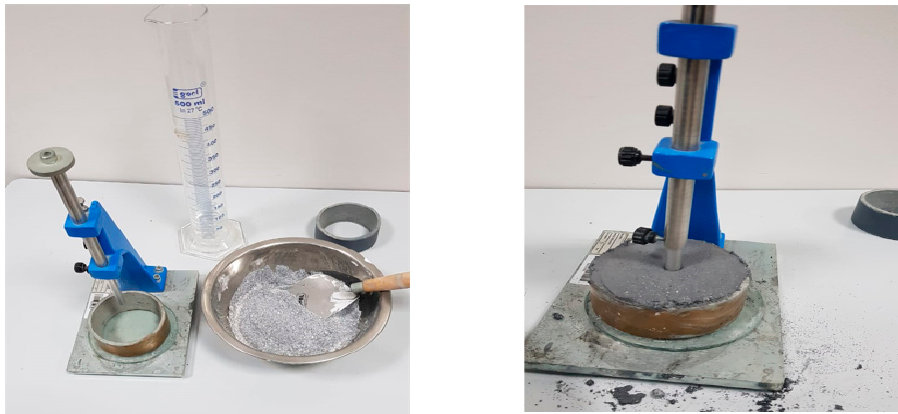
Figure 5. Geopolymer paste preparation for normal consistency test.